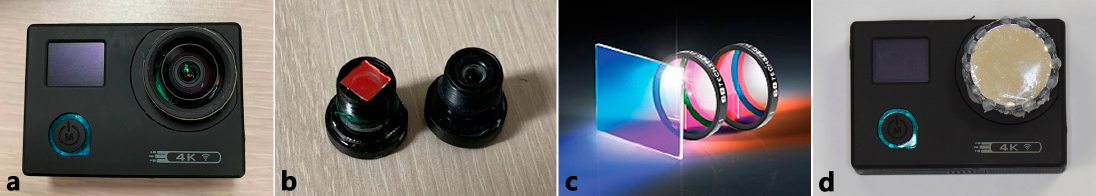
Figure 3. Modified action camera with 7.2 mm lens and band-pass filter. ( a ) SJCAM Pro Action Camera (SJCAM, Shenzhen, China), ( b ) Stock lens with IR filter(left), 7.2 telephoto lens(right), ( c ) Band-pass filter, ( d ) modifed action camera with 7.2 telephoto lens and band-pass filter.